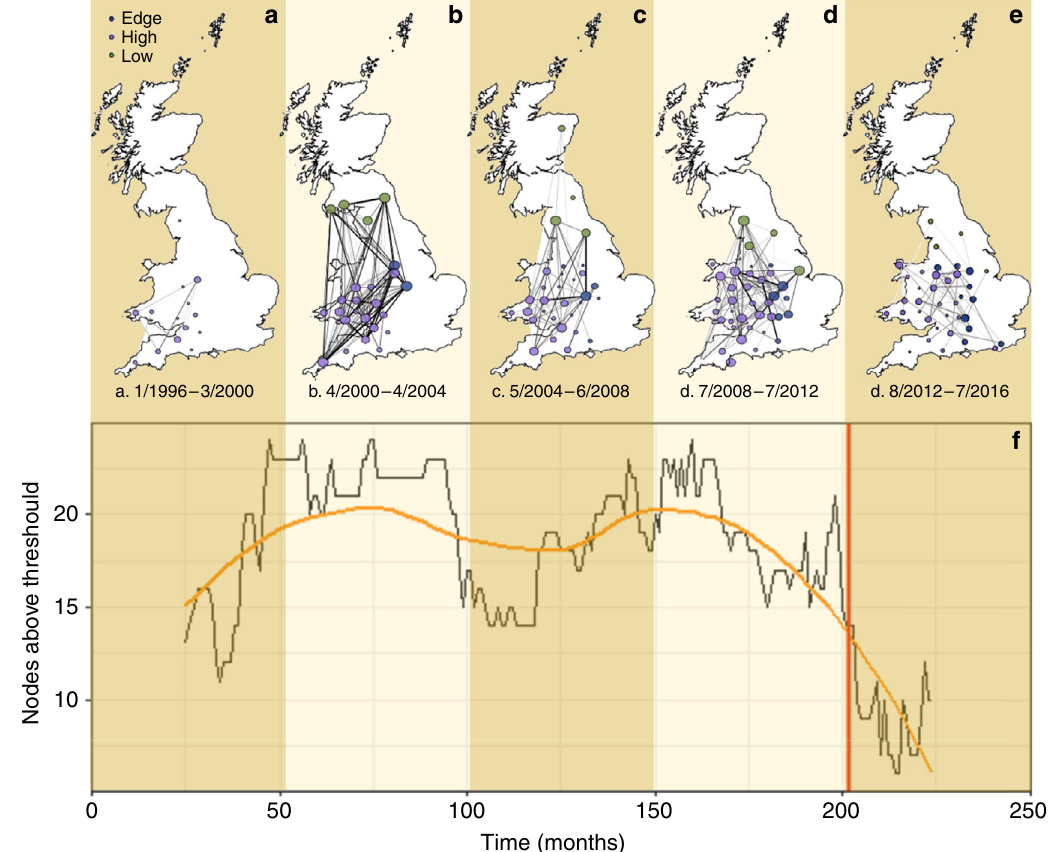
Fig. 3 Spatial synchrony and Network Analysis. Plotted results of correlation matrixes of differences in NHI/TTH per GB counties after the within the county annual variation has been removed. The numbers of nodes indicate the number of counties with high NHI/TTH values (counties above threshold), while the number of connections between nodes, the synchrony amongst them. The thickness of the connecting line between two nodes is proportional to the correlation value between those counties in the corresponding correlation matrix. Only positive correlations are plotted. Low-risk counties are plotted with green, edge with blue, and high risk with purple colour. The data are temporally partitioned into fi ve snapshots as following: a 1/1996-3/2000, b 4/ 2000-4/2004, c 5/2004-6/2008, d 7/2008-7/2012, and e 8/2012-8/2016. f Number of above threshold high-risk counties in England throughout the data set. The vertical red line indicates the introduction of annual testing in January 2013. The orange line is derived from a moving average of 48 months centred in mid value loess regression. The foreground data presented on the image was created by the authors using the methodology described in the methods. The background map of GB Contains OS data © Crown copyright and database right (2016). All rights